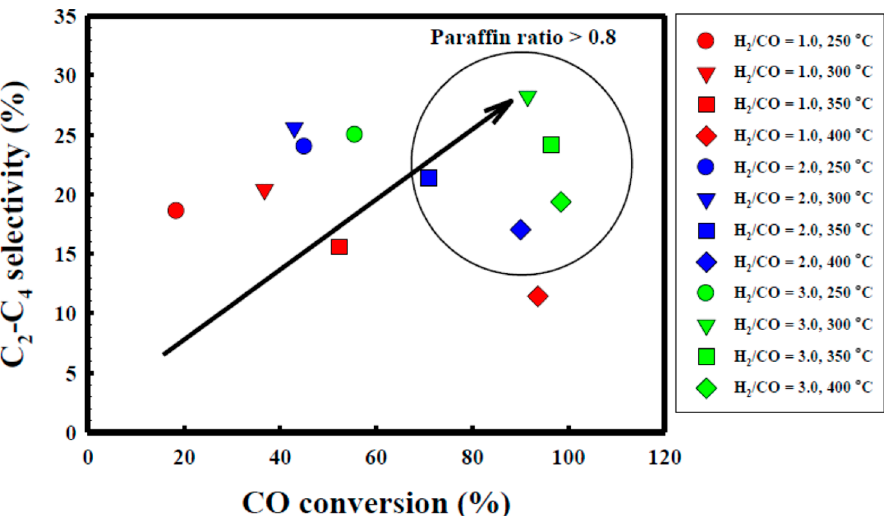
Figure 18. C 2 –C 4 hydrocarbon selectivity as a function of the CO conversion. Reprinted with permission from [104]. Copyright (2018) Elsevier Science BV, Amsterdam, Netherlands.